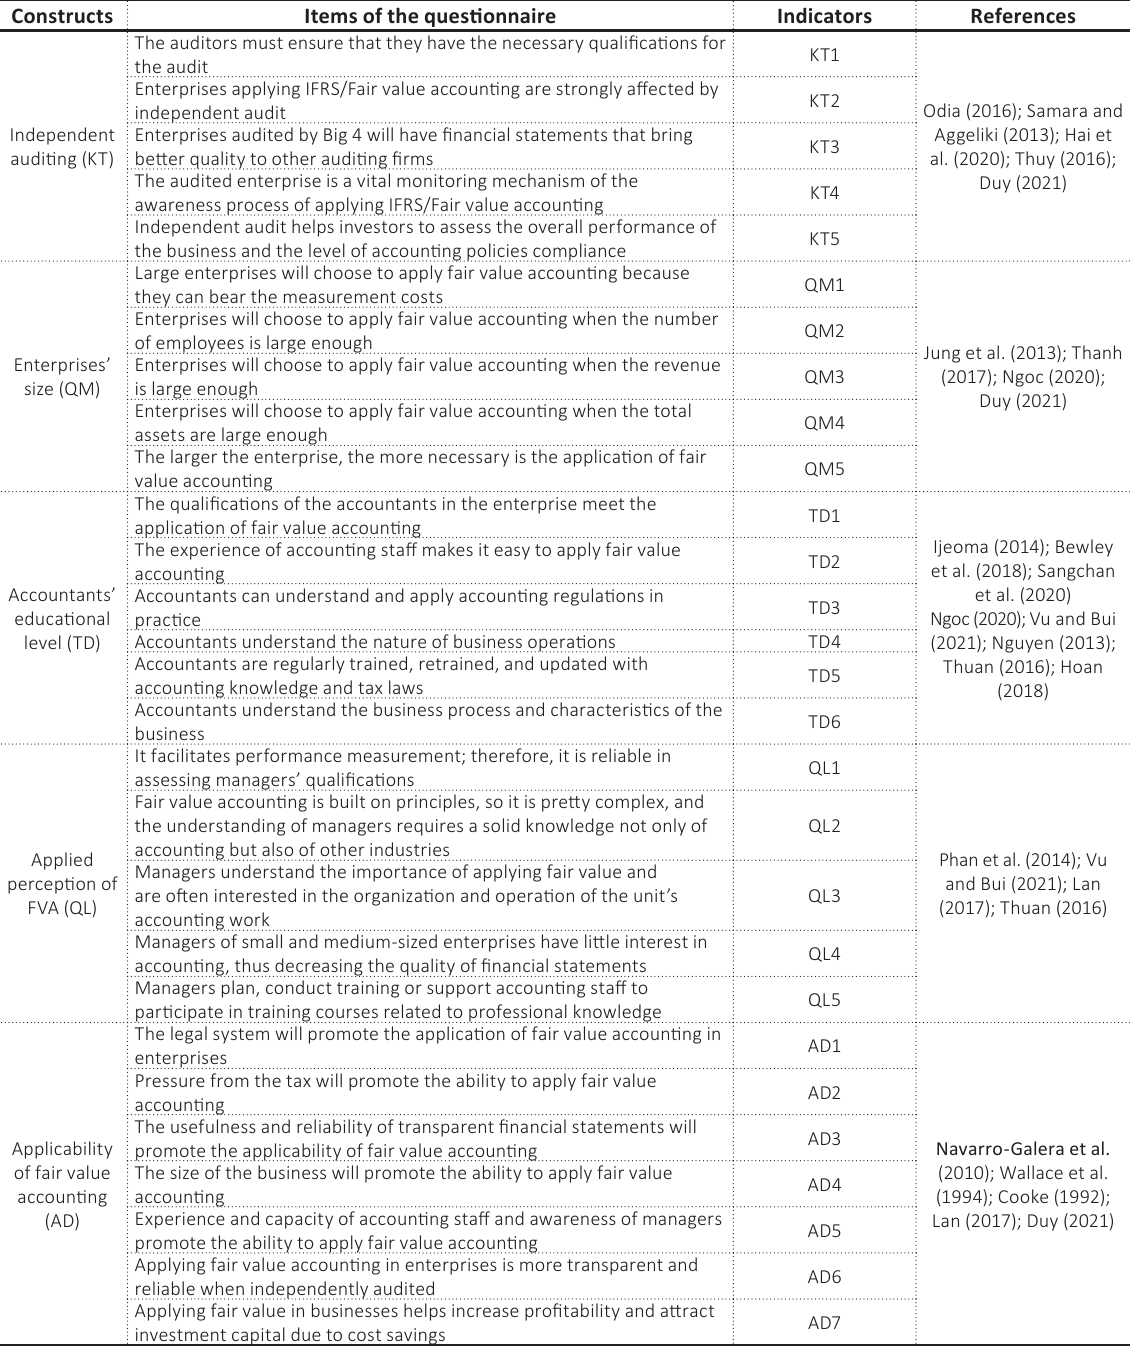
Table A1 (cont.). Constructs, indicators, and questionnaire